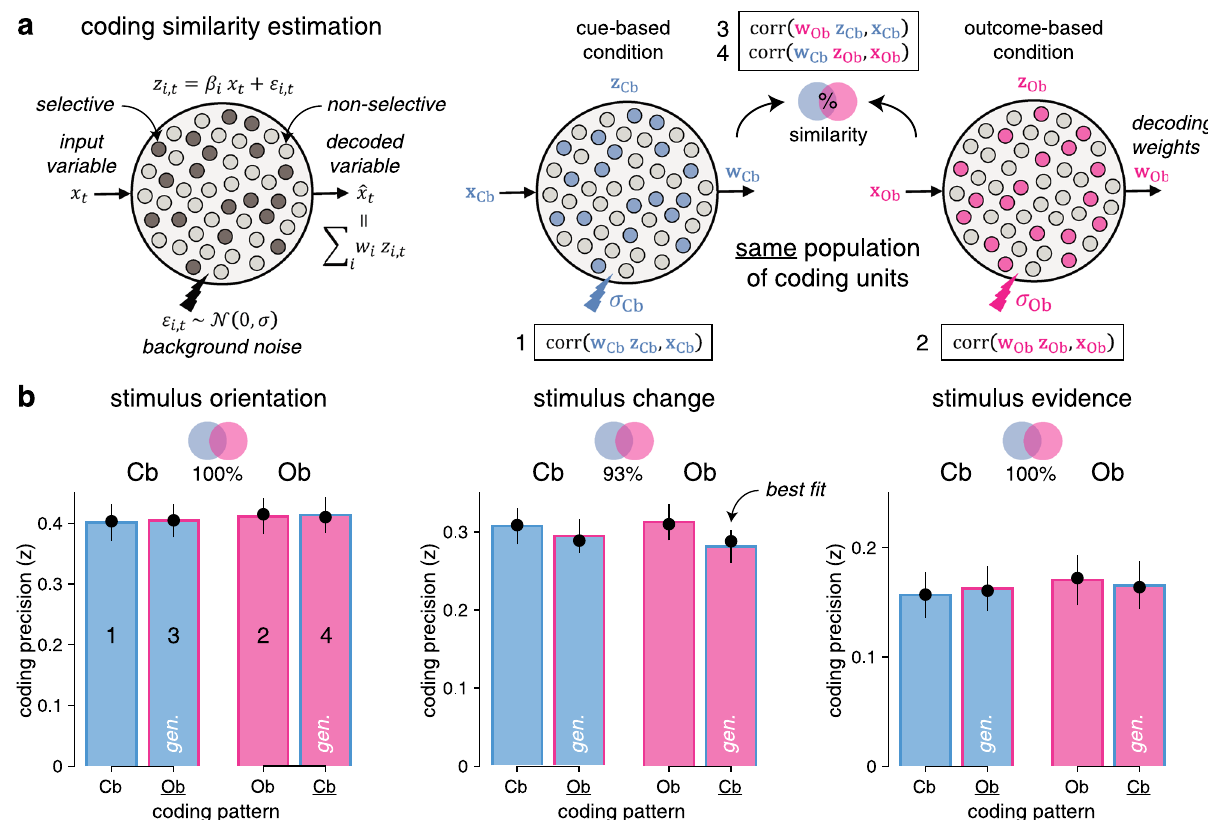
Fig. 5 Estimation of neural coding similarity across conditions. a Graphical description of the coding similarity estimation procedure. Left: a population of linear coding units z i ; t represents an input scalar variable x t by a fraction of “ selective ’ units ( z i ; t ¼ β i x t þ ε i ; t where β i ≠ 0) with background noise ε i ; t of SD σ . A linear decoder is applied to compute an estimate ^ x t of the input variable from population activity. Right: the same population of coding units represents the same input variable x by partially overlapping selective units z in the cue-based (left) and outcome-based (right) conditions. Computing coding precision within each condition (1 – 2) and across conditions (3 – 4, marked by gen., by using the coding weights w estimated in one condition to compute neural predictions in the other condition) allows to quantify the degree of similarity (overlap) between selective units in the two conditions. b Estimated coding similarities for stimulus orientation (left), stimulus change (middle), and stimulus evidence (right). Bars and error bars indicate jackknifed means ± SEM ( n = 24 participants). Dots show predicted values obtained by simulating the population of coding units with best- fi tting estimates of similarity and background noise. Bar fi llings indicate the condition in which neural predictions are computed. Bar outlines indicate the condition in which coding weights are estimated. This procedure indicates near-perfect coding similarity between cue-based and outcome-based conditions for stimulus orientation (left, jackknifed mean: 100%), stimulus change (center, 93%), and stimulus evidence (right, 100%). Source data are provided as a Source Data fi